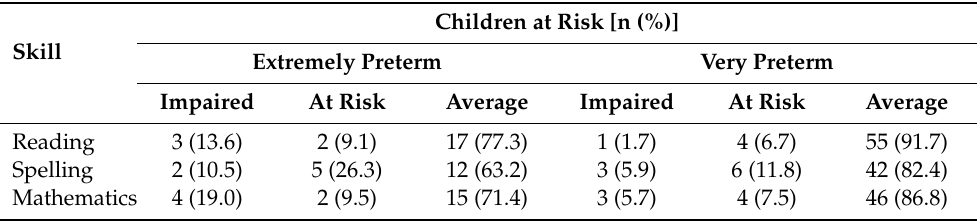
Table 6. Summary of the children in each group as impaired ( ≤− 2 SD), at risk (between − 2 and − 1 SD) or in the average range ( ≥− 1 SD) for the reading, spelling and mathematics skills.